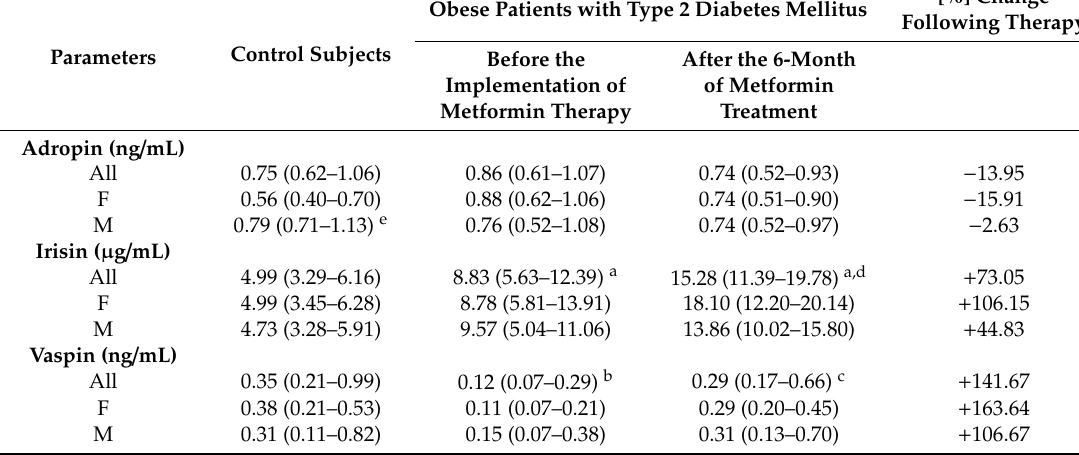
Table 2. Concentrations of plasma adropin, irisin and vaspin in control subjects and obese patients with type 2 diabetes